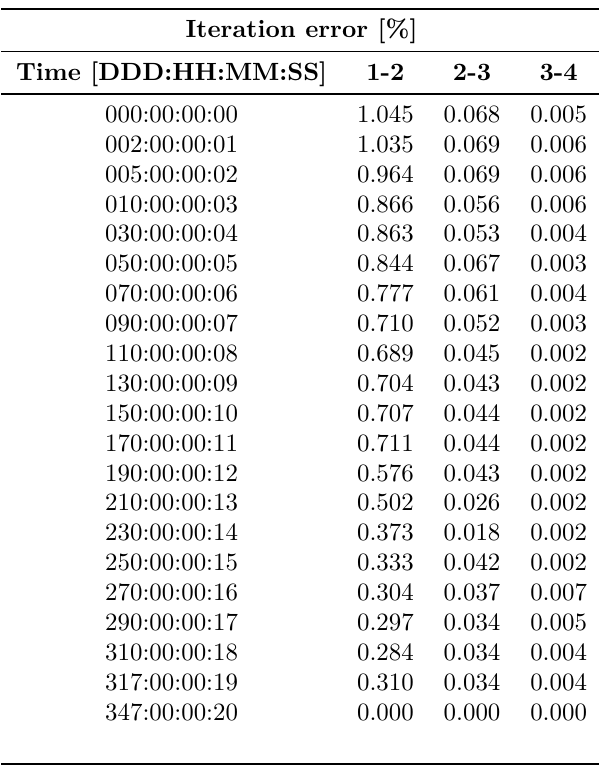
Table 3. Linear power assembly node [W/cm] itera- tion error -